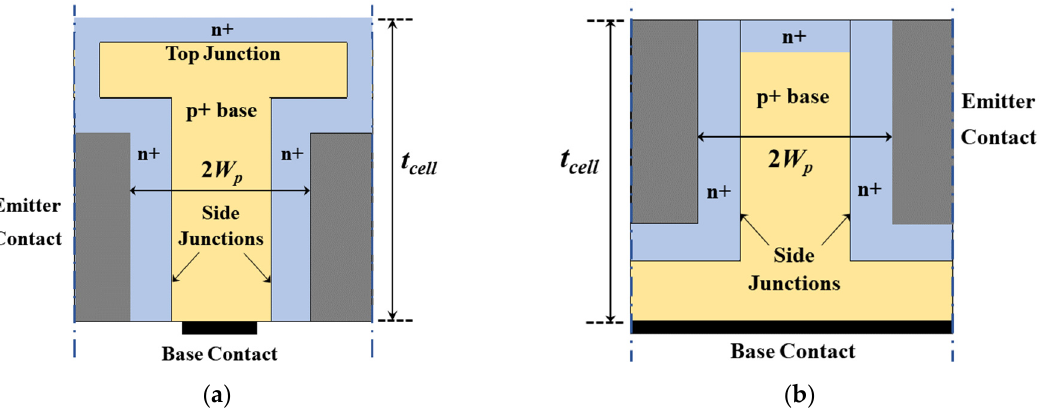
Figure 1. Basic solar cell structures utilized in the study: ( a ) flipped npn microstructure and ( b ) conventional npn microstructure.